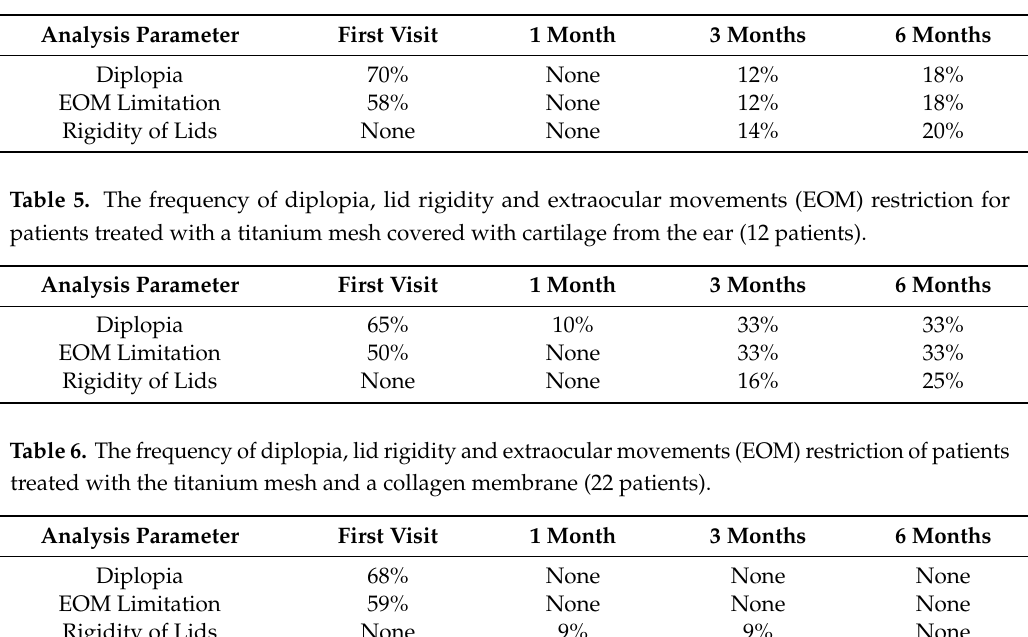
Table 4. The frequency of diplopia, lid rigidity and extraocular movements (EOM) restriction for patients treated only with a titanium mesh (72 patients).